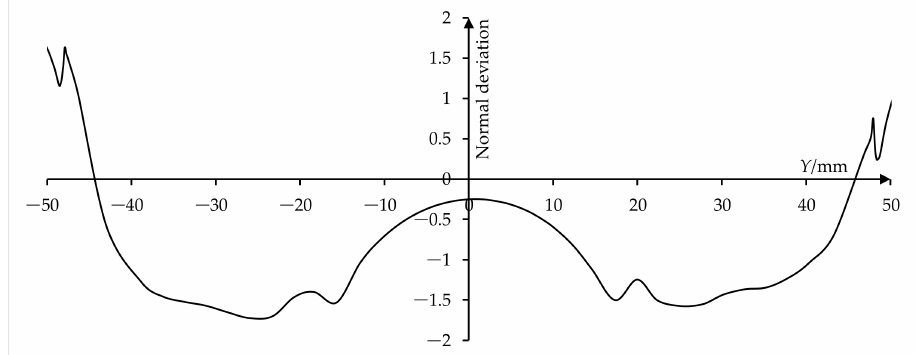
Figure 37. Normal direction deviation of the profile